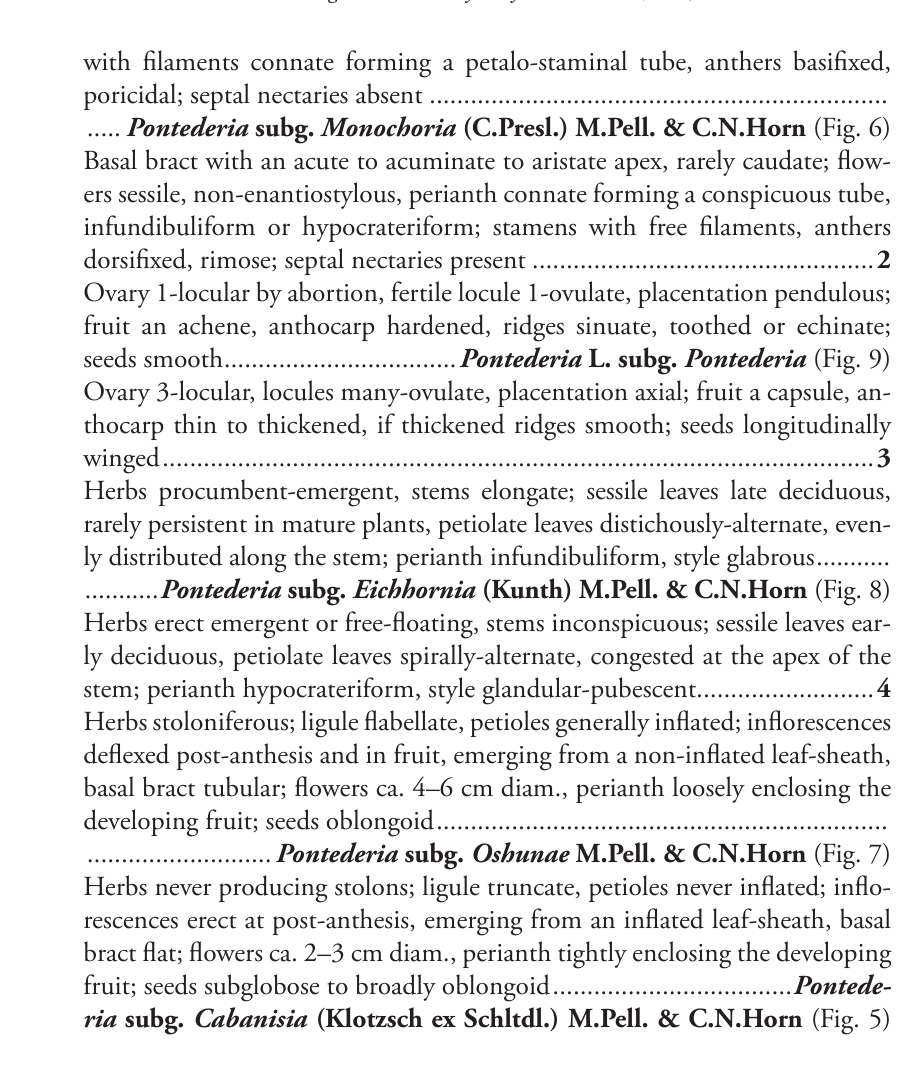
1. Pontederia subg. Cabanisia (Klotzsch ex Schltdl.) M.Pell. & C.N.Horn, comb. et stat. nov. Fig. 5 Cabanisia Klotzsch ex Schltdl., Abh. Naturf. Ges. Halle 6: 176. 1862. Type species (designated here). Cabanisia caracasana Klotzsch ex Schltdl., nom. illeg. ( ≡ P. pan- iculata